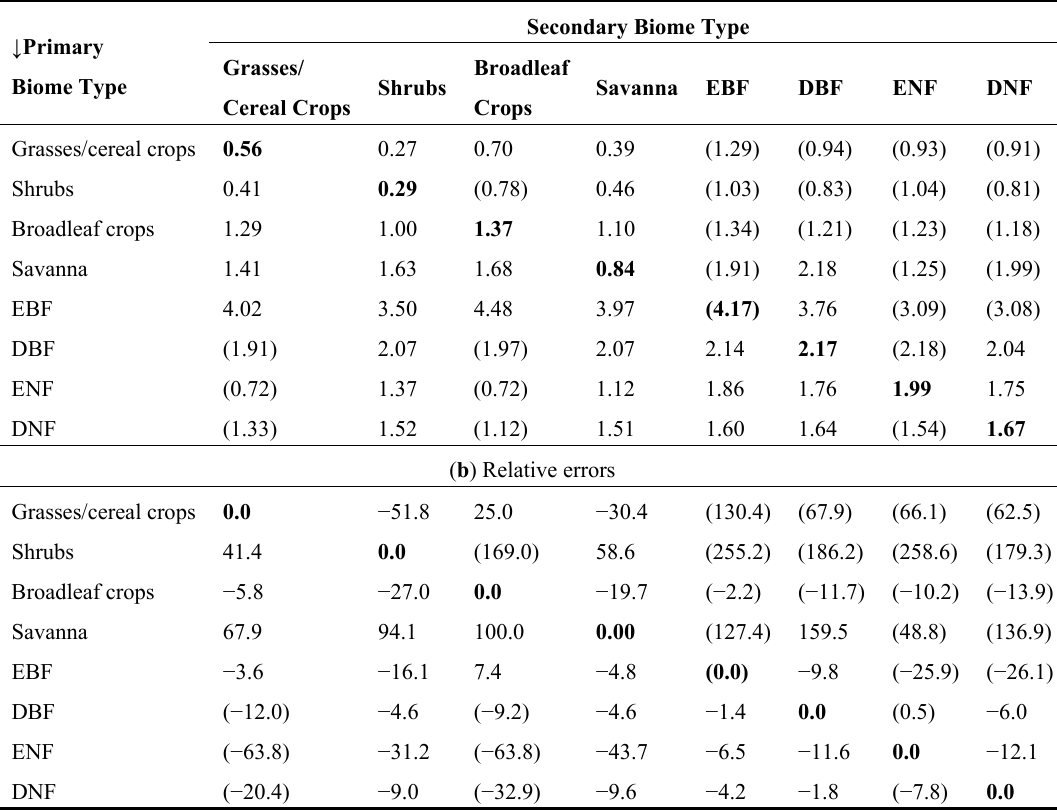
Table 2. ( a ) Confusion matrix for LAI mean values for pure (bold) and mixed pixels and ( b ) the relative LAI errors induced by biome misclassification. Statistics based on data from 2003 − 2009. Mean values for mixed pixels are significantly different from those of the pure pixels ( t -test, p < 0.001). Relative errors are calculated relative to the diagonal pure values. The cells in brackets indicate a smaller number of pixels (<5%) from Table